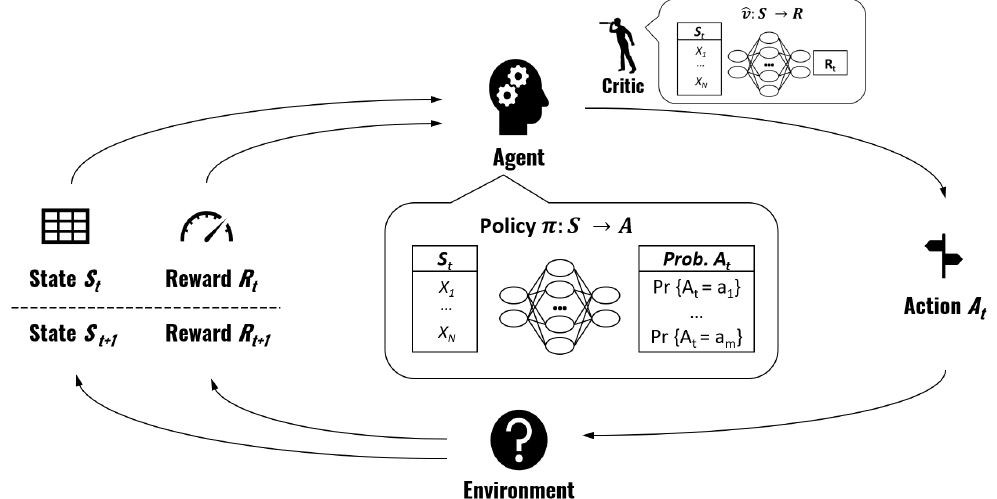
Figure 7. DRL-based actor-critic policy gradient. We use a DRL-based actor-critic policy gradient method. This means that two DNNs are trained. The first DNN parameterizes the policy used by the agent (a.k.a. actor) to map states to probabilities of taking each action. The second DNN parameterizes the critic, which maps states to the reward that it is expected to receive from the environment following the current